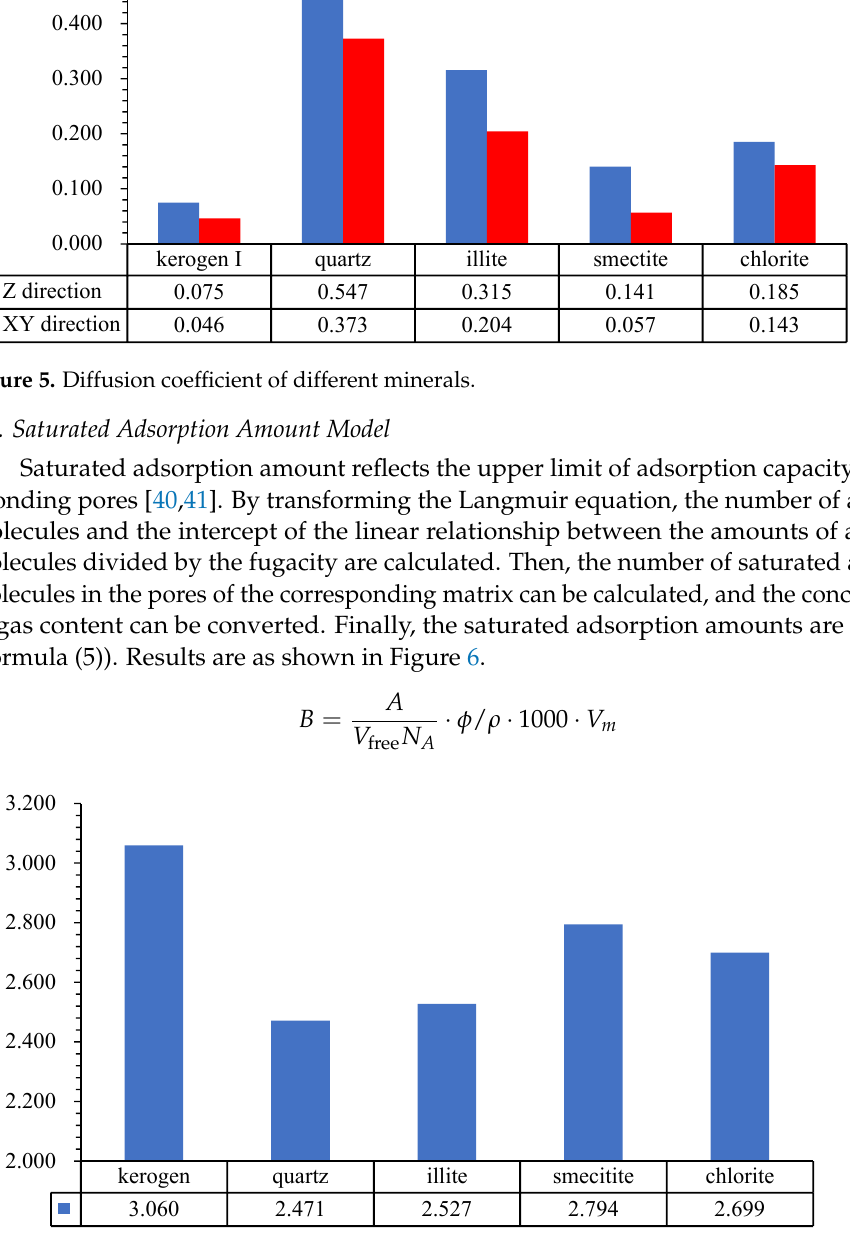
Figure 6. Different saturated adsorption amount of different minerals.